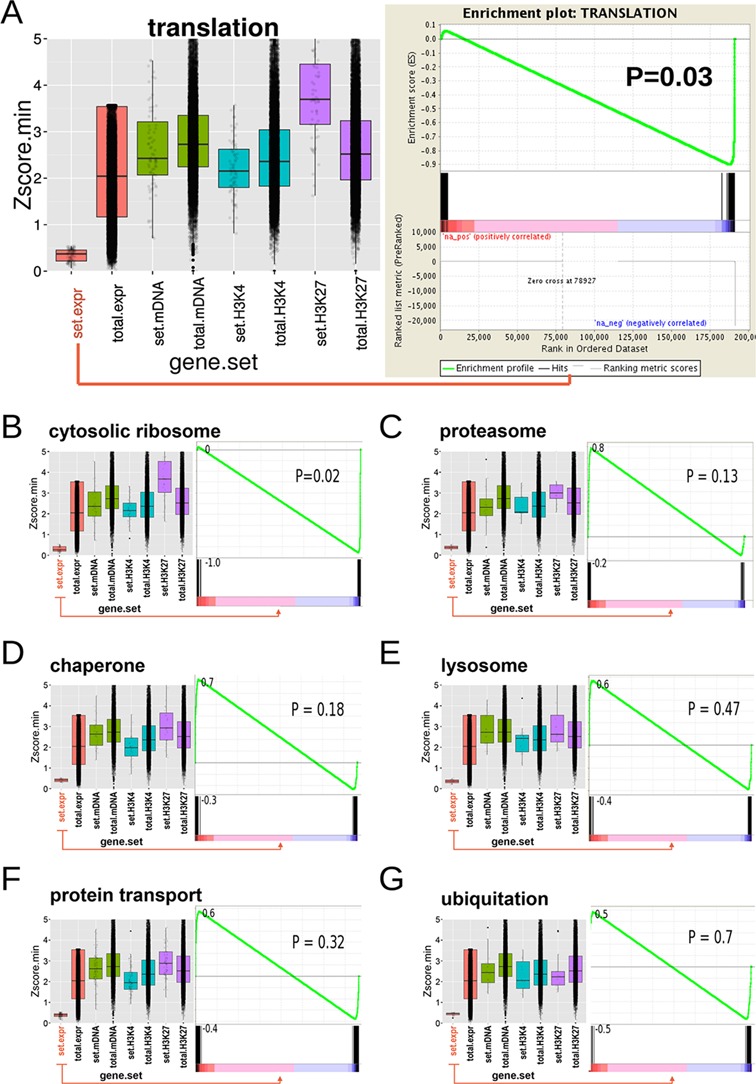
3CA-guided GSEA detecting the most significant gene sets correlated with temporal up- or down-regulation. Temporal expression and epigenetic changes can be evaluated in one plot. For a comprehensive view, we plotted the 3CA score distributions for gene expression (RNA-seq), DNA methylation (meDNA), H3K4-trimethylation (H3K4me3) and H3K27-trimethylation (H3K27me3) for the specific gene sets (set) and for all genes (total) (left panels). In addition to the box charts, we plotted a scattered distribution of the scores (right panels). In this example, we examined the significant 3CA scores for gene expression for matched promoter regions of the epigenetic sets. In order to access the significance for up- or down-regulation, we obtained the temporal changes for the specific gene sets and performed GSEA with the obtained pre-ranked list (40). As we pre-filtered for significant 3CA scores, the respective distribution of temporal changes will be pushed to the edges of the GSEA plots. The values at the y-axis of the enrichment plots are the maximum and minimum enrichment score values obtained from the temporal changes. Shown are all identified processes connected with protein turnover. A: translation, B: cytosolic ribosome, C: proteasome, D: chaperone, E: lysosome, F: protein transport, G: ubiquitination.